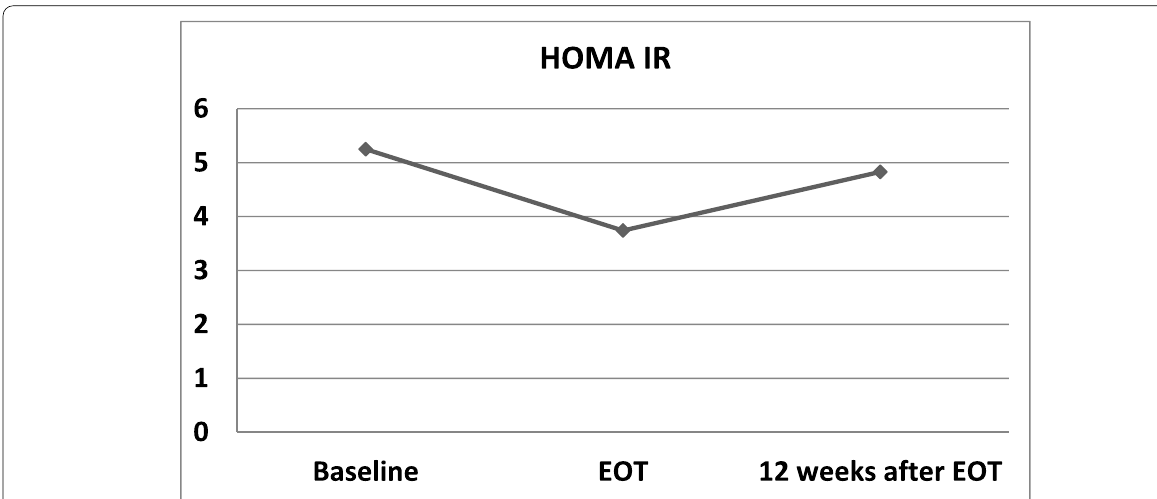
Fig. 1 Changes in HbA1c over the course of the study